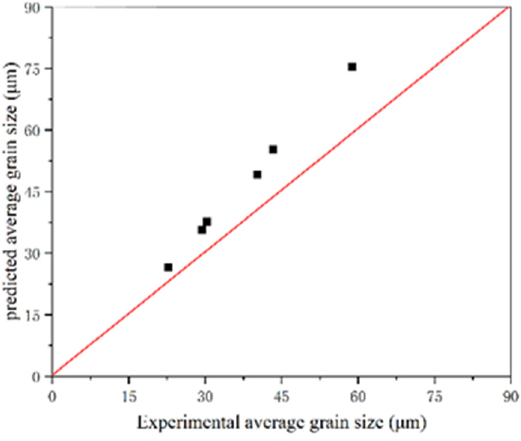
Figure 14. Comparisons of the experimental and predicted average grain sizes.